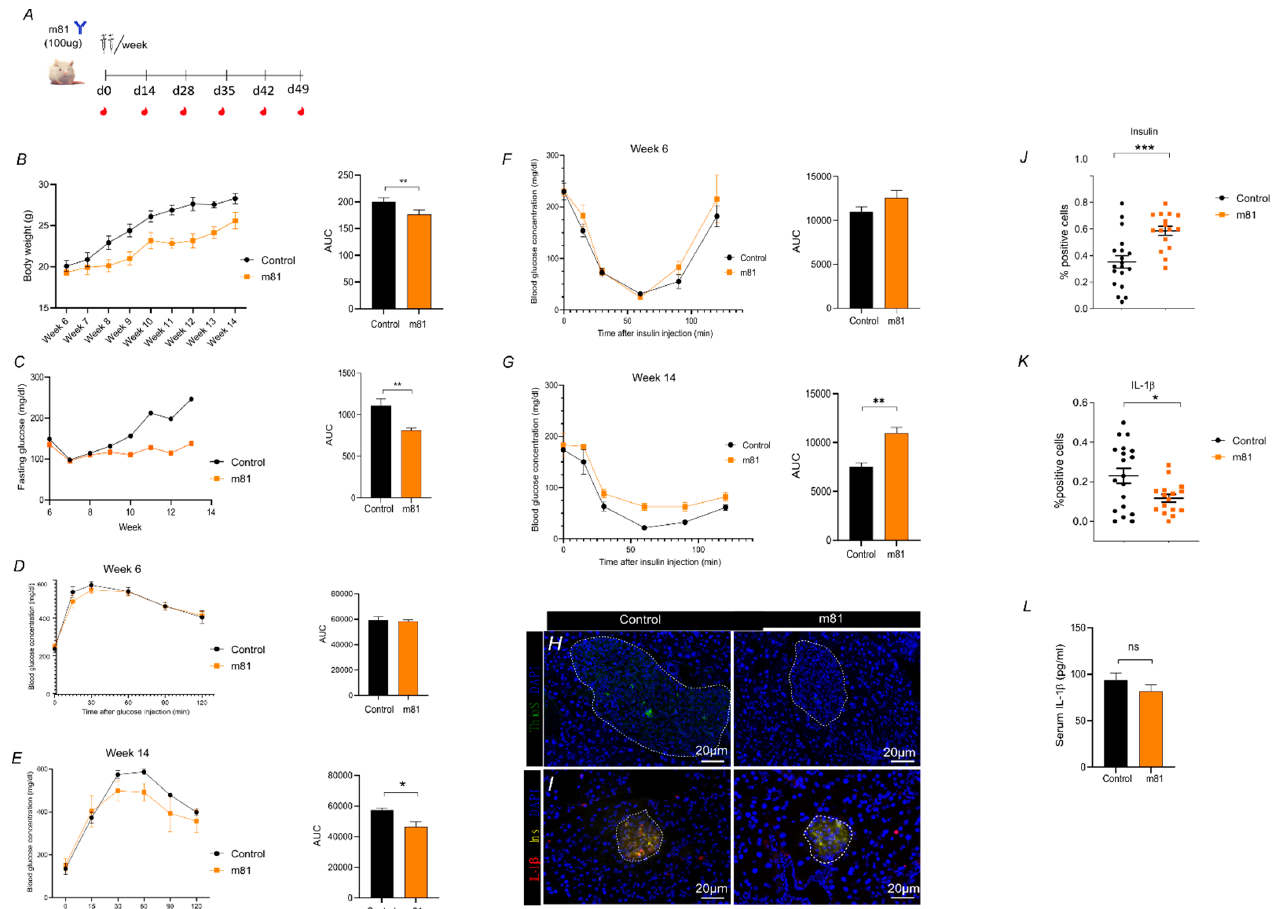
Figure 4. m81 mAb prevents hyperglycemia increase and human IAPP aggregate formation in pancreatic islets, and decreases IL-1 β level. ( A ) Immunization scheme of FVB/Ins2-hIAPP transgenic mice with 100 µ g of m81 mAb or control buffer for each injection. Mice received two injections/week. Blood was collected for Ab titer check. ( B ) Body weight [g] over 13 weeks of m81 mAb immunized (orange square) and control (black circle) mice, with corresponding area under the curve (AUC). ( C ) 14h-fasting glucose level [mg/dl] of m81 mAb immunized (orange square) and control (black circle) mice, with corresponding area under the curve (AUC). n = at least four mice per group. Statistics performed by unpaired t-test, where the immunized (m81 mAb) group is compared to the control (PBS) group. ** p < 0.01. ( D ) Glucose Tolerance Test at age of 6 weeks, with corresponding area under the curve (AUC). n = four mice per group. ( E ) Glucose Tolerance Test at 14 weeks of age, with corresponding area under the curve (AUC) n = four mice per group. Statistics performed by unpaired t-test, where the immunized (m81 mAb) group is compared to the control (Isotype) group. * p < 0.05. ( F ) Insulin Tolerance Test at age of 6 week, with corresponding area under the curve (AUC). n = four mice per group. ( G ) Insulin Tolerance Test at age of 14 week, with corresponding area under the curve (AUC). n = four mice per group. ( D – G ) Statistics performed by unpaired t-test, where the immunized (m81 mAb) group is compared to the control (Isotype) group. ** p < 0.01. ( H ) Pancreatic islets showing deposited hIAPP (ThioS, green) in control (left panel), m81 mAb immunized (right panel). Nuclei are stained in blue (DAPI). ( I ) Presence of pro inflammatory cytokine IL-1 β (IL-1 β , in red), insulin (Ins, in yellow), and nuclei (DAPI, blue) in control (left panel), m81 mAb immunized (right panel) ( J ) Quantification of insulin (left) and ( K ) IL-1 β positive islets of control (black dot) and m81 mAb immunized (orange square) mice. n = 19 islets. ( J – L ) Statistics performed by unpaired t-test, where the immunized (m81 mAb) group is compared to the control (PBS) group. ** p < 0.01, *** p <0.001. m81 mAb clone m81; hIAPP, human amylin; IL-1 β , interleukin-1 β ; ThioS, ThioflavinS, Ins, insulin; DAPI, 4 ′ ,6-Diamidine-2 ′ -phenylindole dihydrochloride. Scale bars: 20 μ m. (L) IL-1 β levels (pg/mL) in the serum of mice ( n = 4) at 16 weeks of age determined by